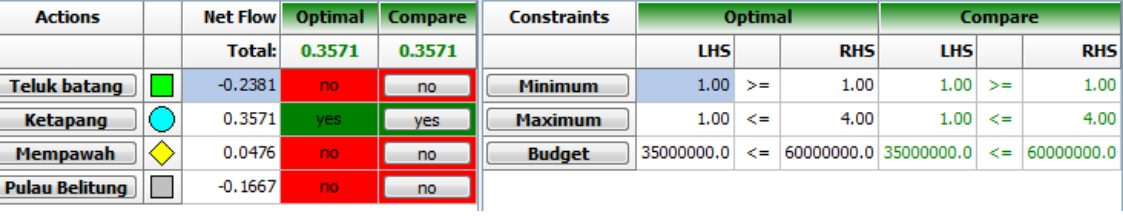
Figure 7. Net flow obtained from PROMETHEE V.